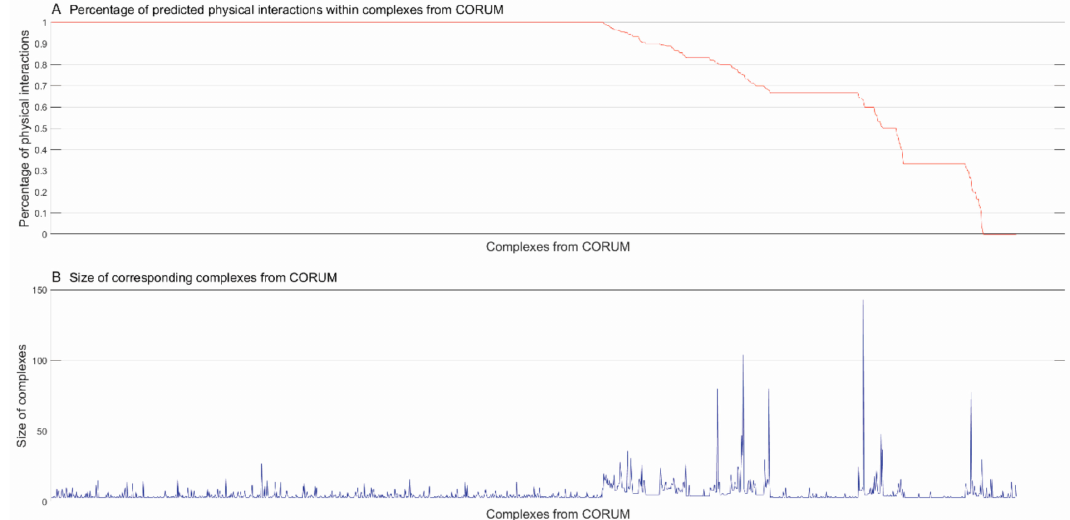
Figure 3. Percentage of predicted physical interactions within complexes in CORUM [4]. ( A ) The predicted connection degrees of complexes in CORUM [4] in descending order; ( B ) the actual size of corresponding complexes in CORUM